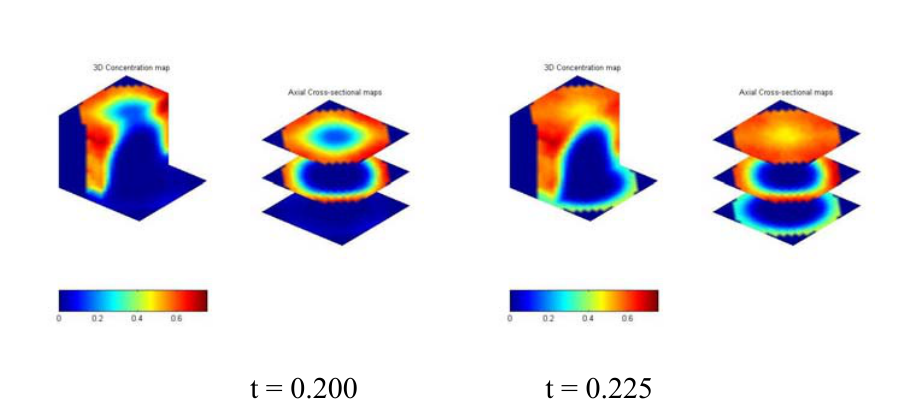
t = 0.200 t = 0.225